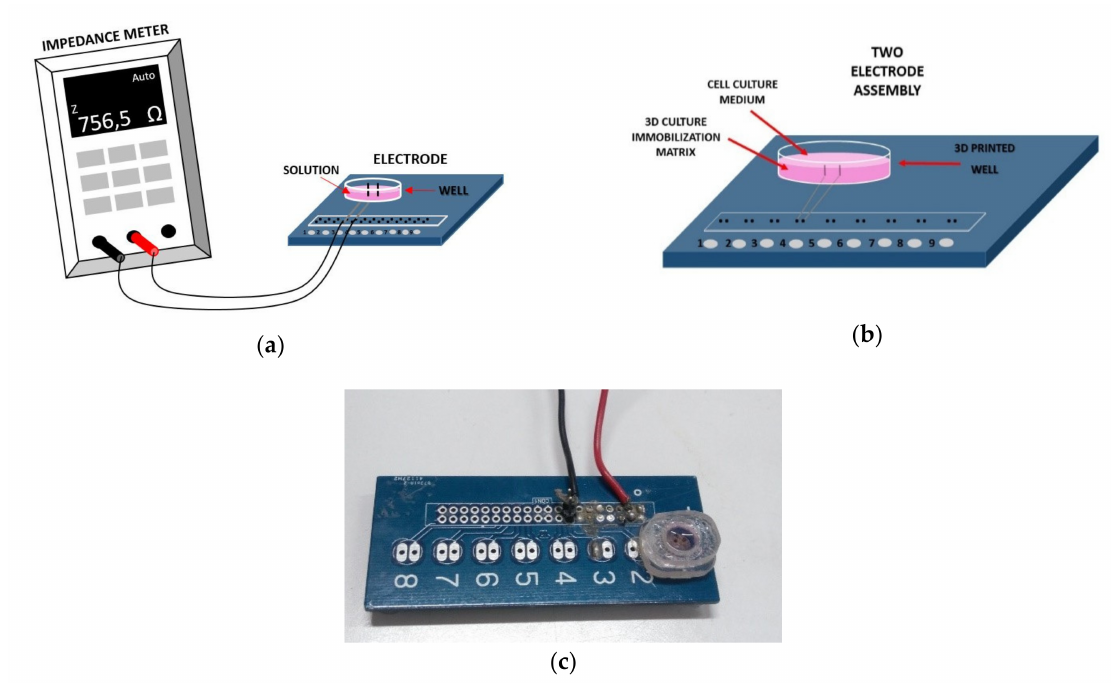
Figure 1. ( a ) Experimental setup. The electrode is connected to the LCR (Inductance (L), Capacitance (C), and Resistance (R)) meter. ( b ) Cross section of the cell chamber filled with 3D immobilization matrix. ( c ) Picture of the well and the electrodes